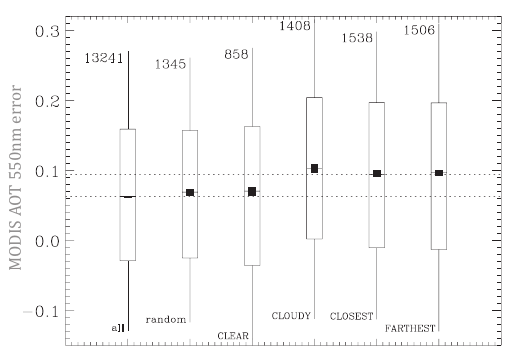
Fig. 2. MODIS Terra AOT error statistics for 0.5 ≤ MODIS AOT ≤ 2.5 depending on sampling strategies. The box denotes the 25–75% interquantile range and the whiskers the 10–90% interquantile range. The median is denoted by the horizontal bar in the box. The number given for each box and whisker refers to sample